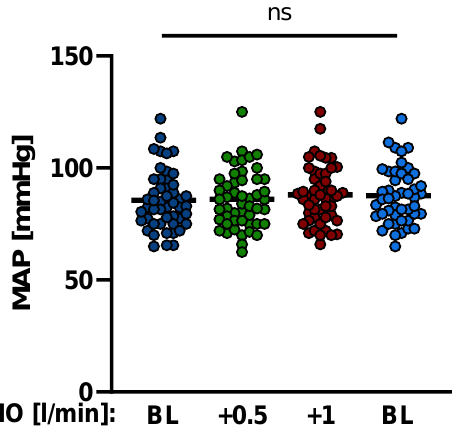
Figure 2. Variation of mean arterial pressure (MAP) during Impella ® support. MAP remained without significant change during the measurements. (IO: Impella output; BL: baseline; ns: not significant, p ≥ 0.05).